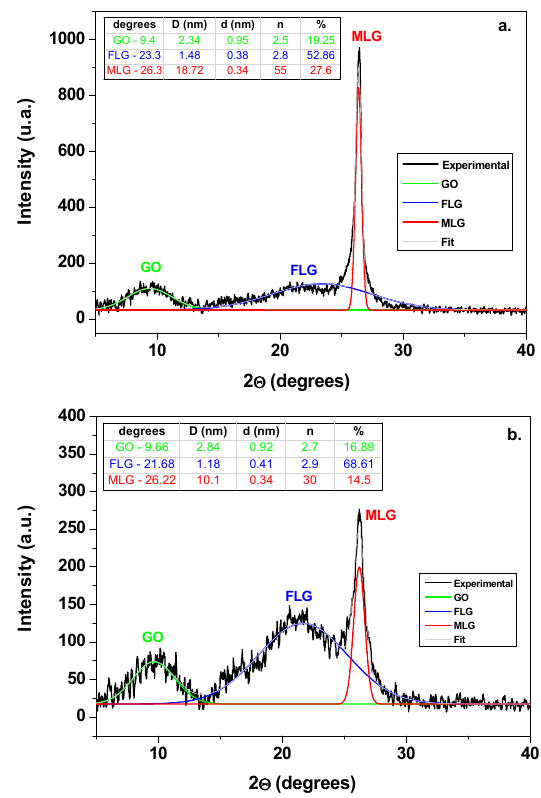
Figure 6. The XRD pattern of EGR-1 sample and the corresponding structural parameters ( a ); the XRD pattern of EGR-2 sample and the corresponding structural parameters ( b ).